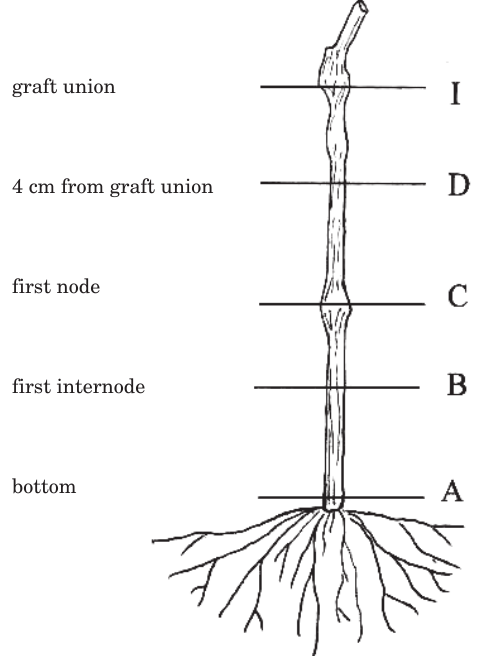
Fig. 1. Positions along the axis of a grafted-rooted vine where isolations were